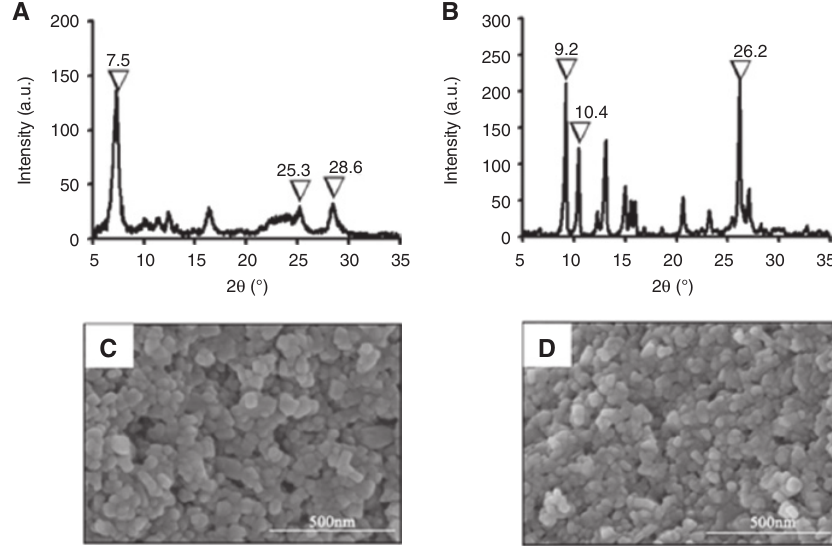
Figure 2: The crystal form and particle size of TiOPc NPs. (A, B) The XRD patterns of the TiOPc NPs obtained from H photographs of the TiOPc NPs obtained at 288 and 338 K,